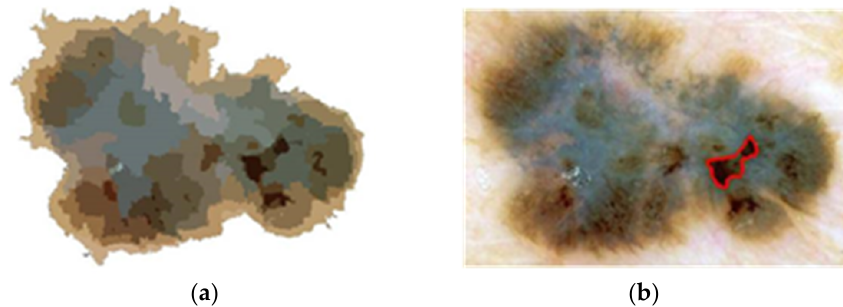
Figure 4. Detection of irregular pigmentation: ( a ) Lesion map; ( b ) area of interest.